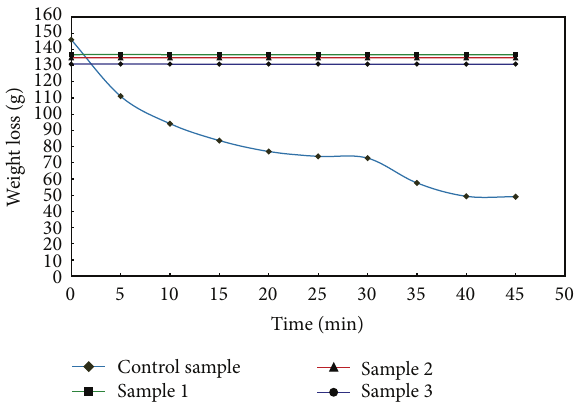
Figure 5: Weight loss versus time at 5 m/s wind speed.